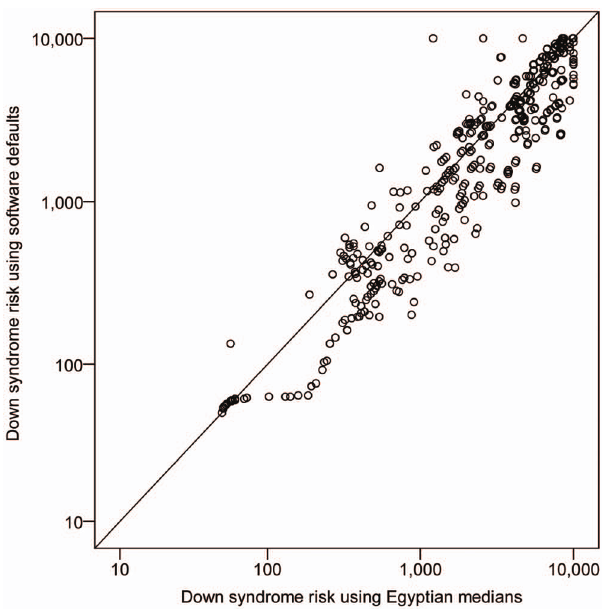
Figure 2. Comparison between risks (1:n) generated using Egypt-specific medians and software default medians.